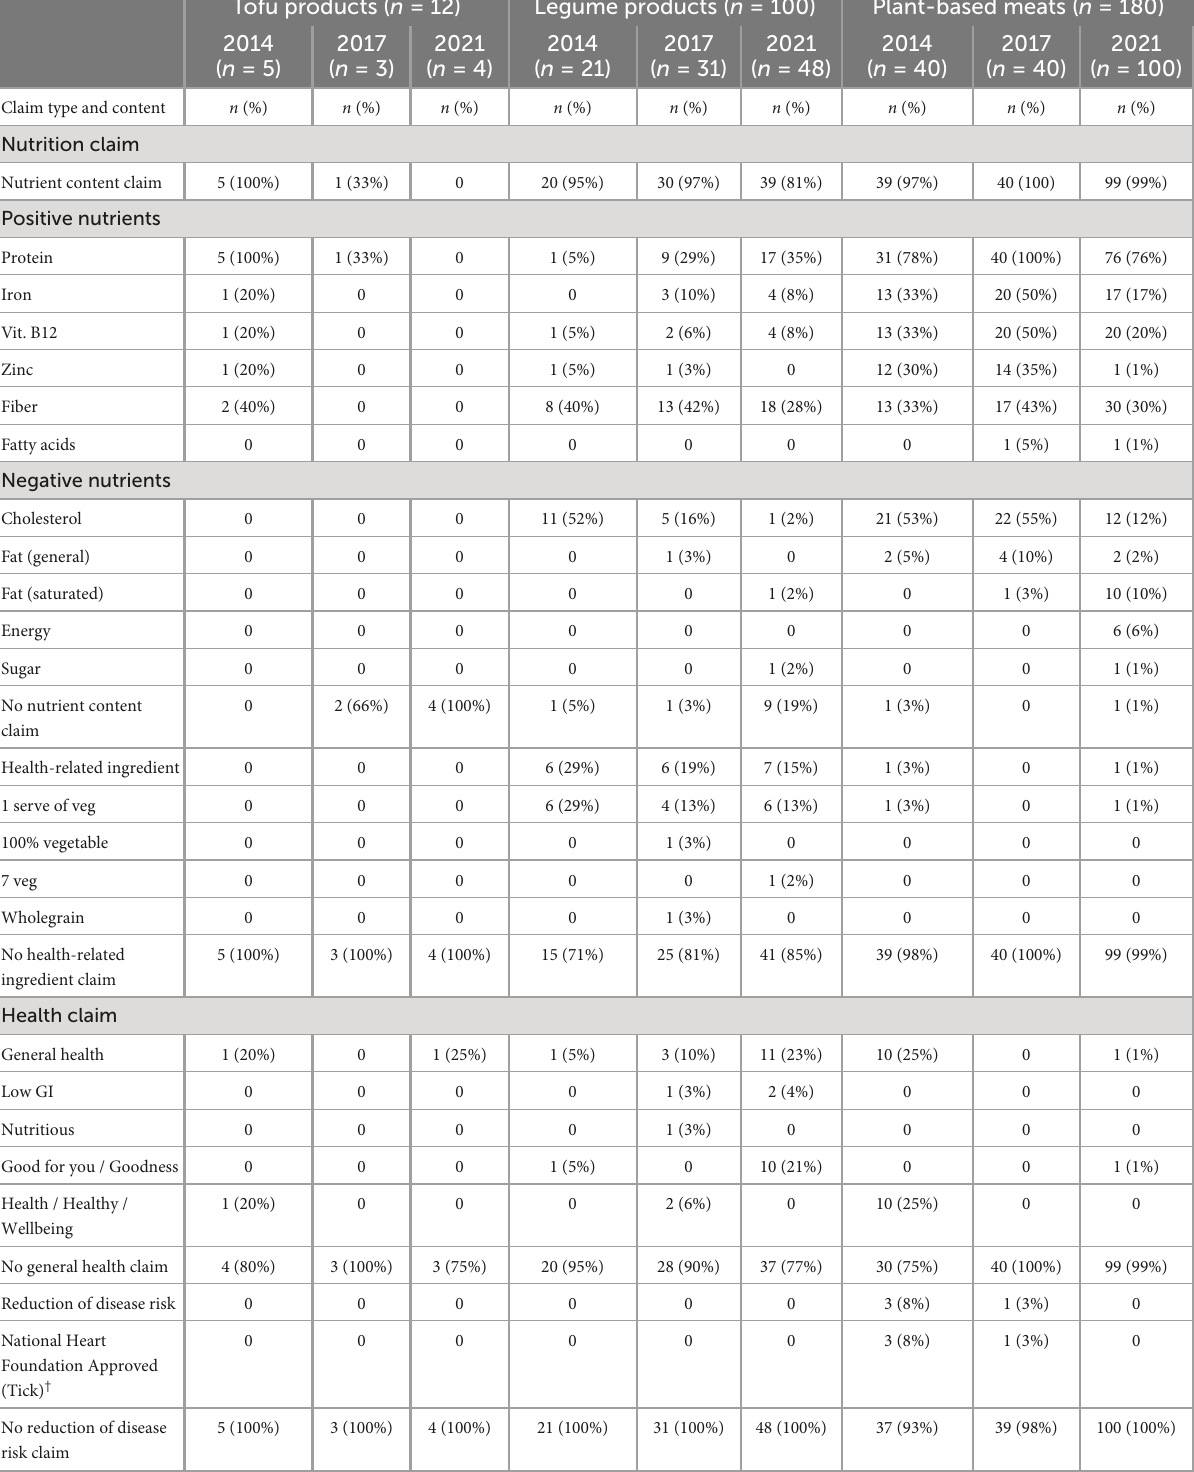
TABLE 5 Content on the front of pack label in 2014, 2017, and